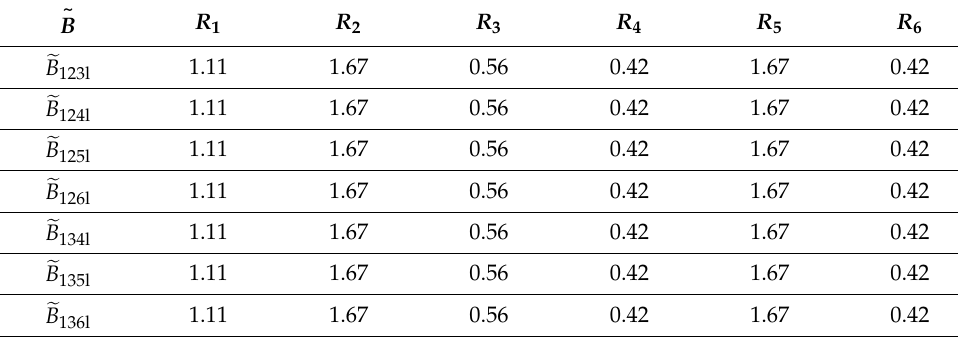
Table 4. Results of weight matrix calculation (cid:101) B